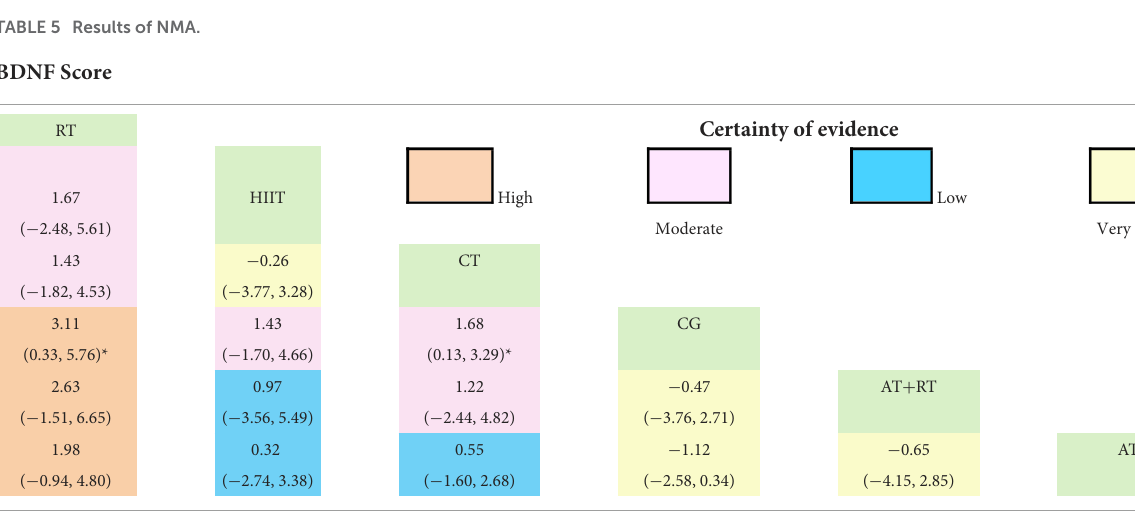
TABLE 5 Results of